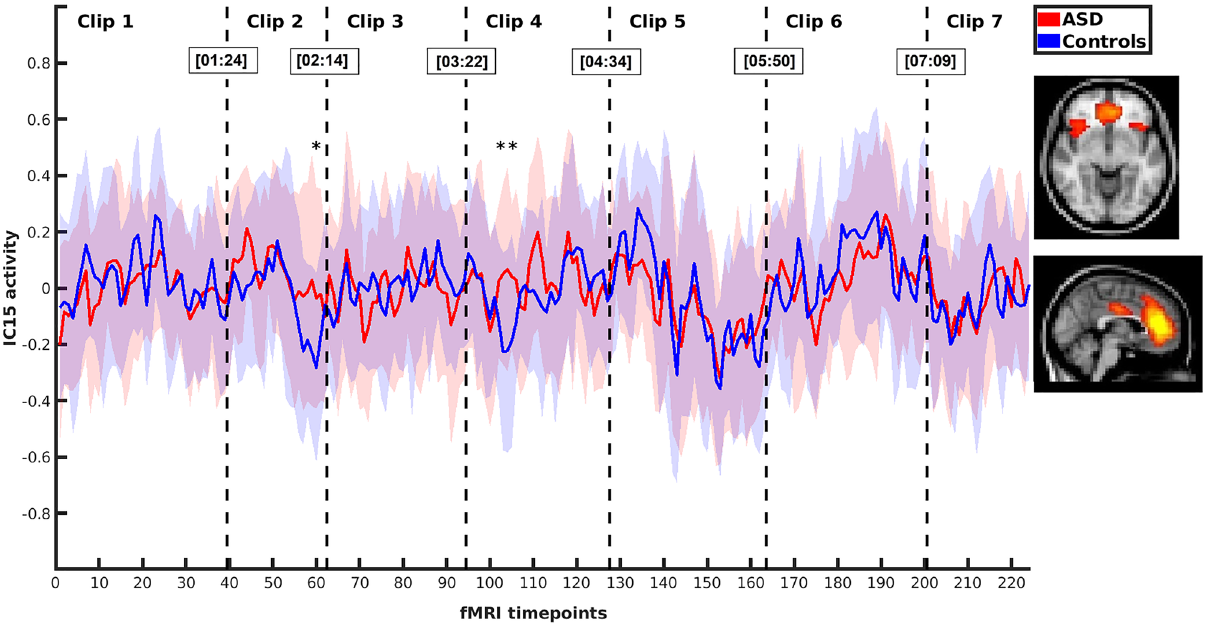
Figure 3. Average activity (± SD ) of IC15 in the ASD and NT groups during video clips 1–7 (* = significant difference after combining probability over IC4, IC15 and IC27).